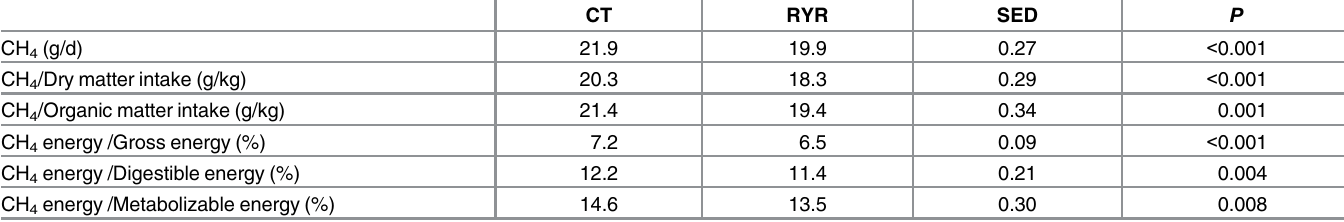
(P = 0.035) in the diet RYR than in diet CT. Table 5. The effect of replacement of ordinary rice with red yeast rice on enteric methane emission in goats (n = 20). CT RYR SED P CH 4 (g/d)